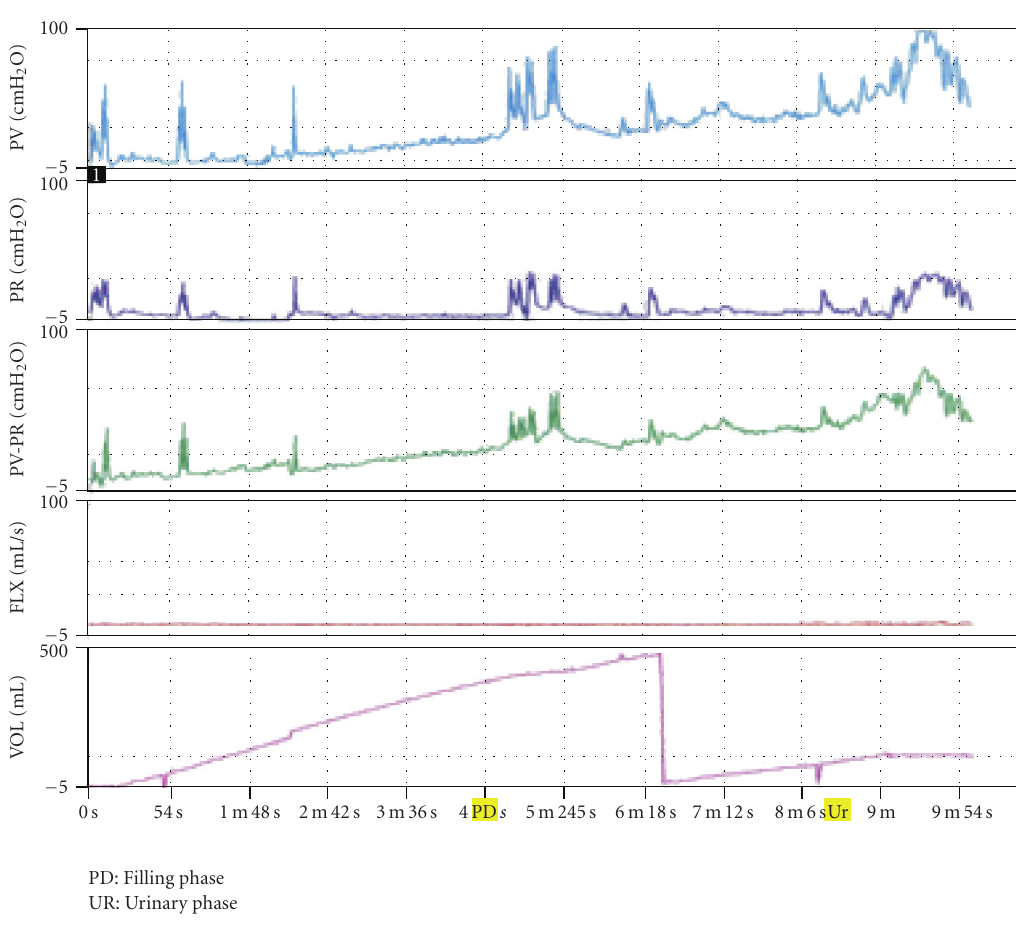
Figure 1: Urodynamic study performed on patient (2008) showing detrusor hyperreflexia prior to voiding. PV: vesicular pressure, PR: abdominal pressure, PV-PR: detrusor pressure, Vol: volume in